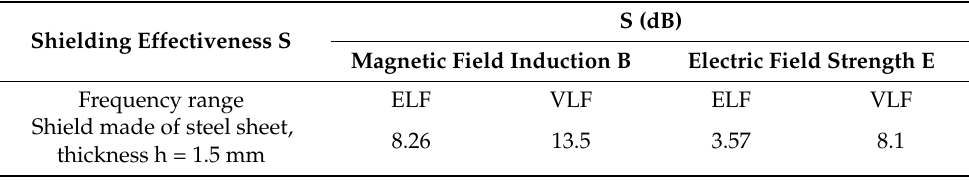
Table 2. Magnetic field induction B and electric field strength E shielding effectiveness over the described ELF and VLF ranges for individual shields (shield is the metal container housing, with a sheet thickness h—1.5 mm).